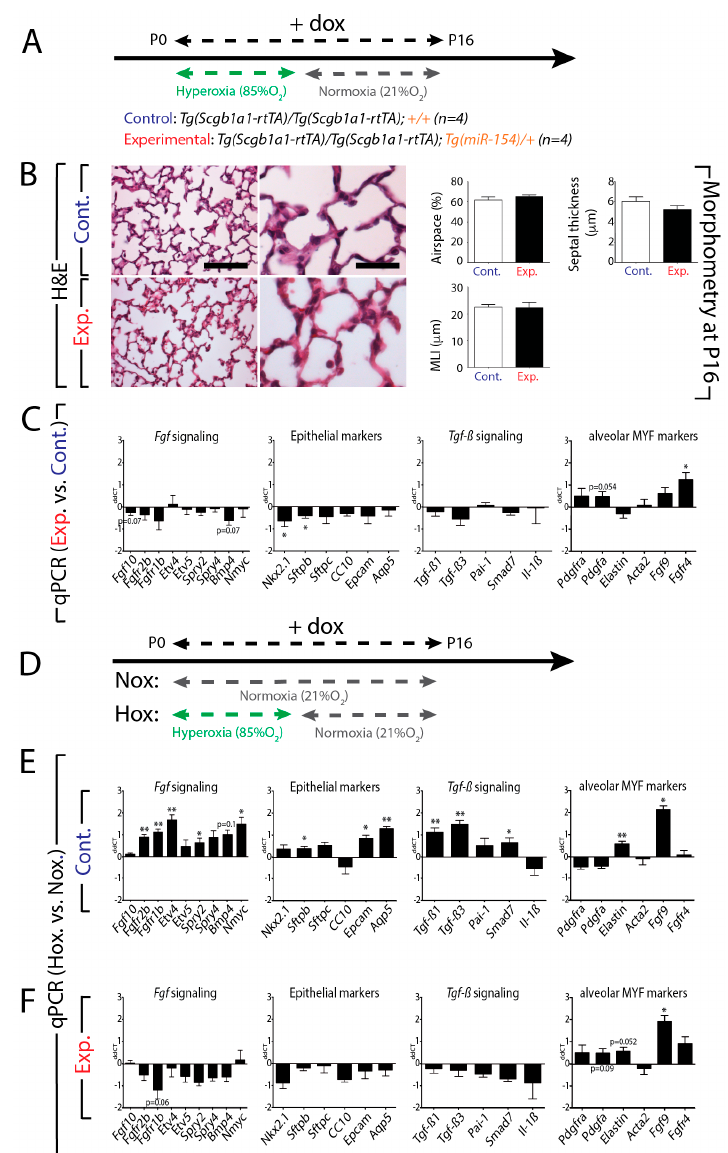
Figure 6. Hyperoxic lung injury on top of overexpression of miR-154 (double injury) compared to miRNA overexpression only (single injury): A . Model of hyperoxic treatment and doxycycline (Dox) administration in order to activate miR-154 overexpression. B . Alveolar Morphometry reveals no further effect of double injury (hyperoxia and miRNA overexpression) on alveolar parameters compared to single injury ( miRNA overexpression only). C . RT-qPCR data show no obvious effect of additional hyperoxic injury on top of miR-154 overexpression for Fgf signaling, Tgf- β signaling and epithelial cell markers. Merely genes connected to alveolar myofibroblast formation and function seem to be a ff ected by additional hyperoxic exposure. (HOX and NOX each n = 4). D . Model of either normoxia or hyperoxia treatment in control and experimental mice. E . RT-qPCR analysis in the control mice reveals a global increase in Fgf signaling as well as the associated alveolar epithelial markers ( Sftpb , Epcam and Aqp5 ), Tgf- β signaling was also increased ( Tg-f β 1 , Tgf- β 3 , Smad7 ). F . The data from experimental mice suggest no significant changes for Fgf signaling, the epithelial markers and Tgf- β signaling. Scale bar in B: low magnification: 125 µ m; high magnification: 50 µ m. * p ≤ 0.05, ** p ≤ 0.01, *** p ≤